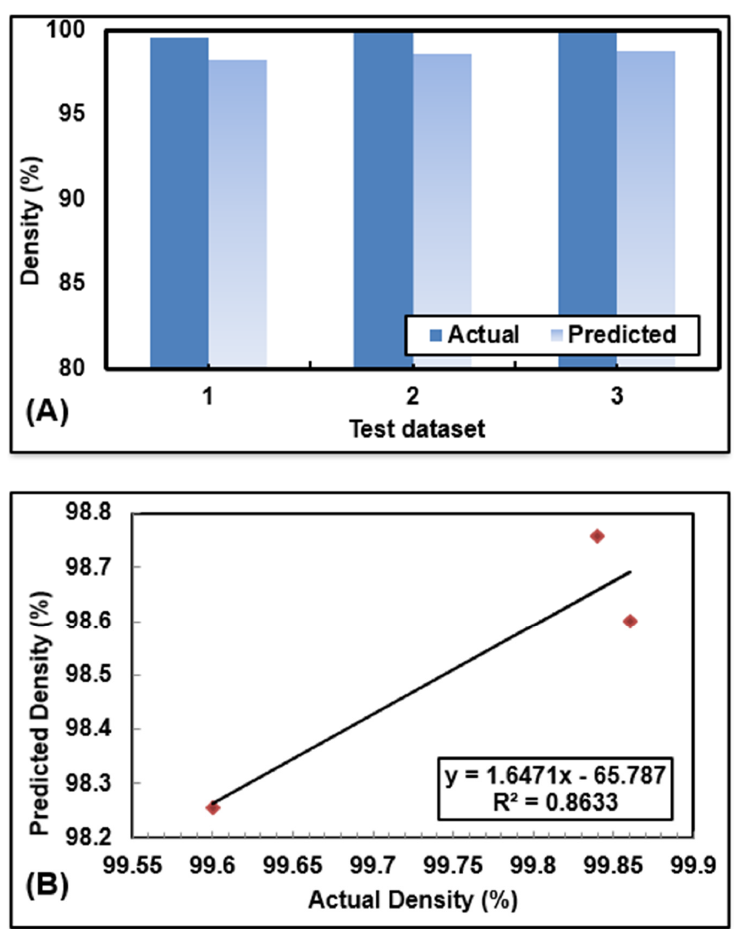
Figure 8. The optimum value of k ‐ numbers for RMSE.